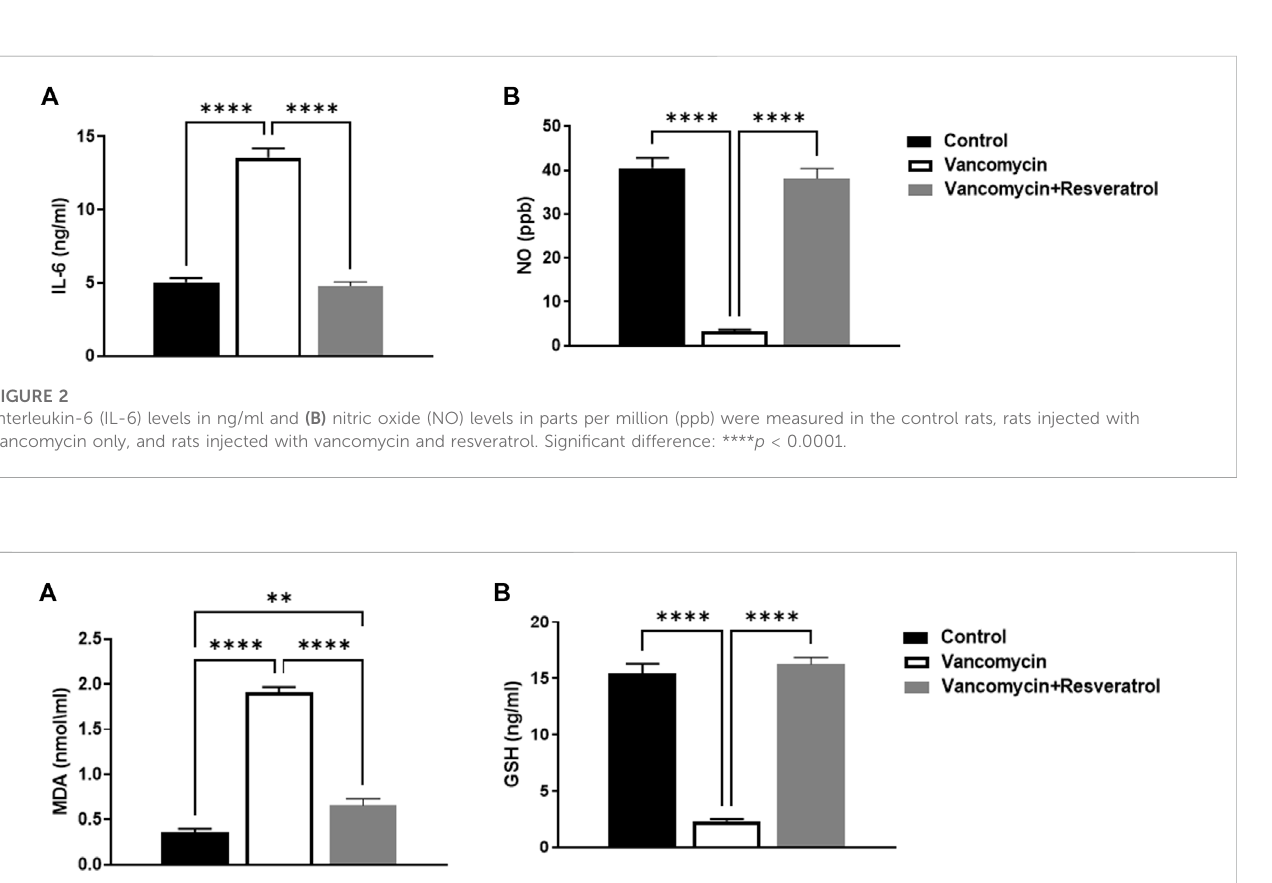
FIGURE 3 (A) Malondialdehyde (MDA) (nmol/ml) and (B) Glutathione (GSH) levels in ng/ml were measured in the control rats, rats injected with vancomycin only, and rats injected with vancomycin and resveratrol. Signi fi cant difference: ** p < 0.001; **** p <